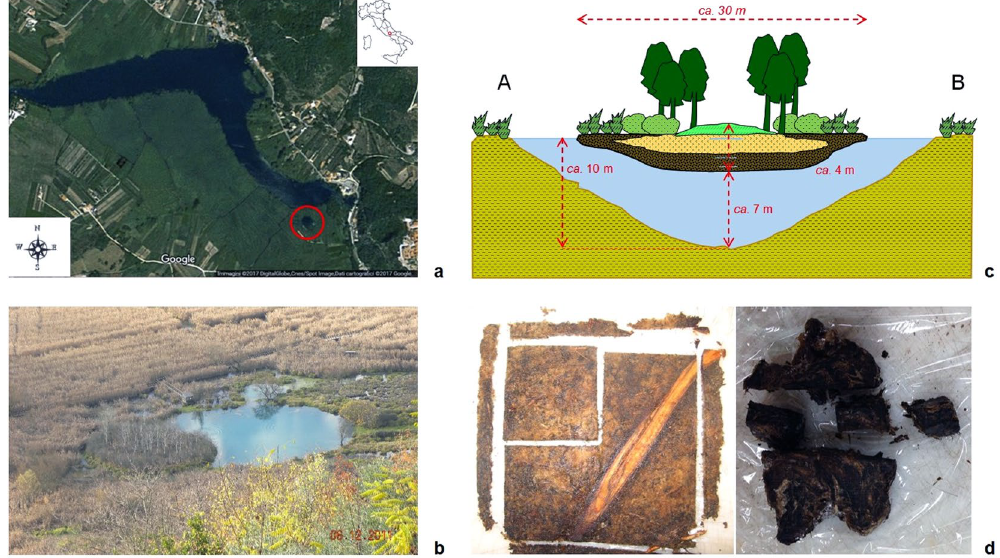
Figure 1. The Posta Fibreno floating island (“la Rota”). ( a ) Aerial view of the Posta Fibreno lake (source: Image ©2017 DigitalGlobe, Cnes/Spot Image, Dati cartografici ©2017 Google), with a red circle surrounding the floating island. The map in the top right corner was created using QGIS v. 2.14 software (http://www.qgis.org/ it/site/). ( b) The Posta Fibreno free-floating island (photo by C.Z.). ( c) Schematic representation of the studied floating mire (drawn by C.Z). ( d) The shallow (left) and deep (right) peat samples (photos by C.Z.).